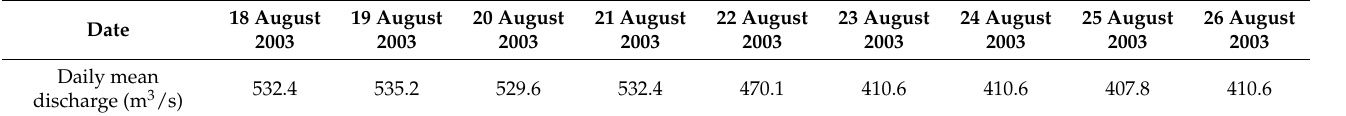
Table 6. Observations of volume flow in Kootenai River.